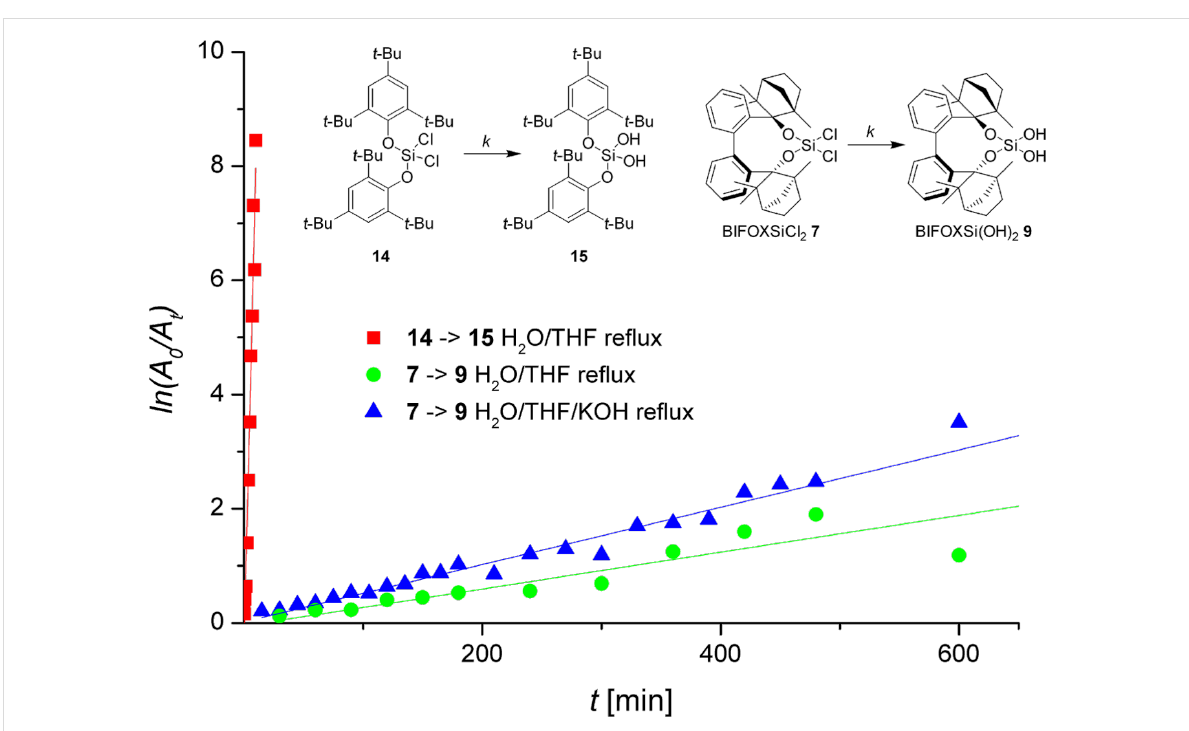
Figure 3: Hydrolyses of BIFOXSiCl 2 ( 7 ) to BIFOXSi(OH) 2 ( 9 , green circle), bis(2,4,6-tri- tert -butylphenoxy)dichlorosilane ( 14 ) to bis(2,4,6-tri- tert - butylphenoxy)silanediol ( 15 , red square) in H 2 O/THF reflux and BIFOXSiCl 2 ( 7 ) to BIFOXSi(OH) 2 ( 9 , blue triangle) H 2 O/THF/KOH reflux conditions (Scheme 3 and Scheme 4). Reaction constants are evaluated with ln ([ A 0 ]/[ A t ]) = k·t for a pseudo-first-order reaction plotted against reaction time (Table 2). Reflux conditions are: H 2 O/THF ≈ 77 °C, H 2 O/THF/KOH ≈ 80 °C.